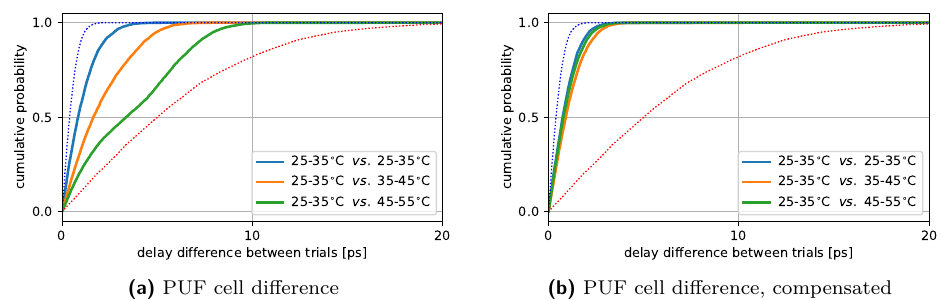
Figure 11: Cumulative distribution of within-class distances when compensation is, or is not, used. Dashed lines show for comparison the results from Fig. 9a, which are collected under default conditions without disturbance from oscillators.